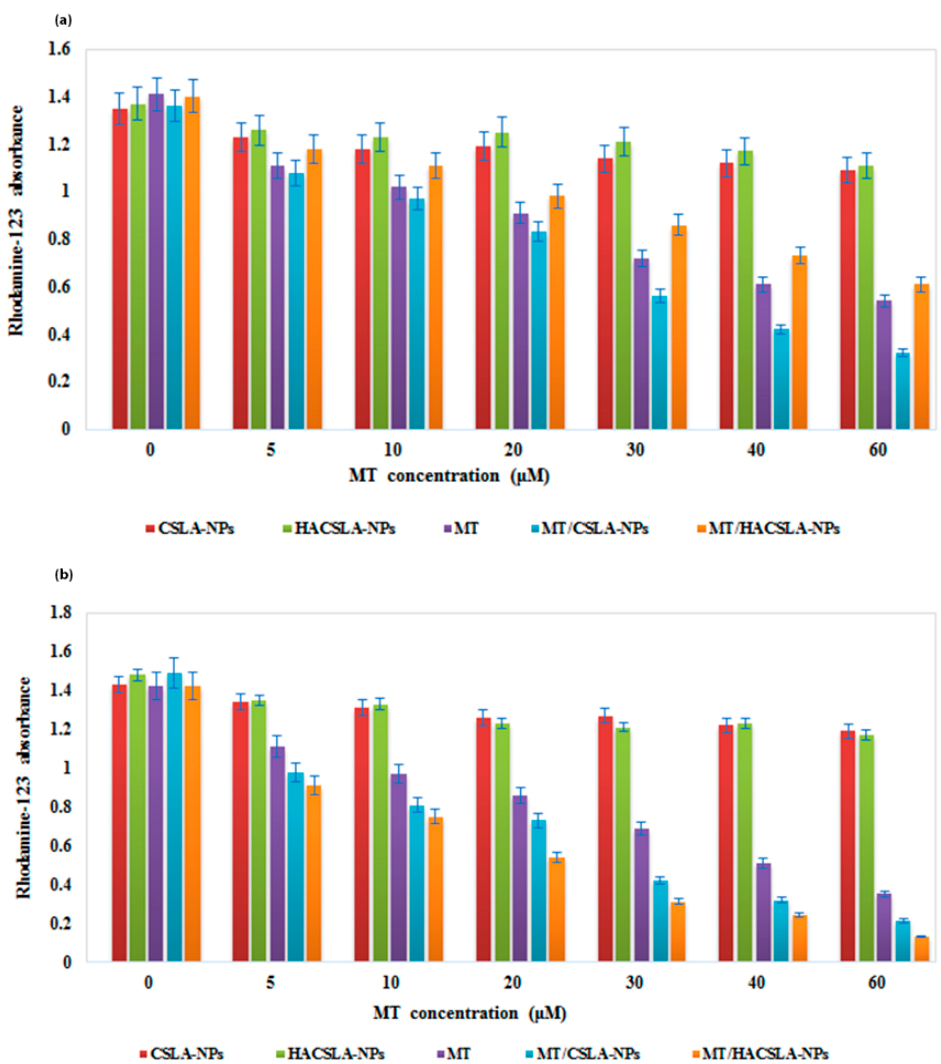
Figure 10. The effects of different treatments on the cell death on ( a ) MCF-7 and ( b ) BT-20 cells. All data represented by mean ± S.E.M. ( p < 0.05).